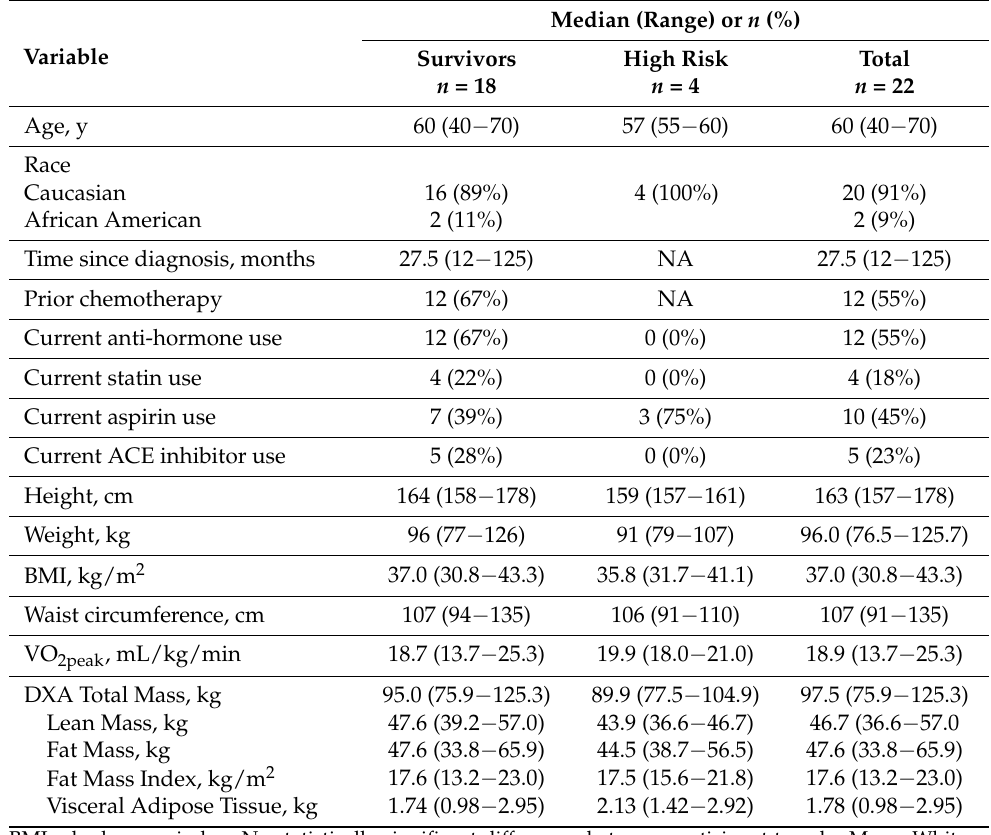
Table 1. Baseline characteristics of 22 participants in the